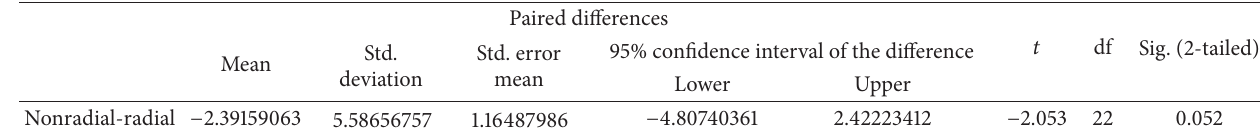
Table 12: Paired samples test.